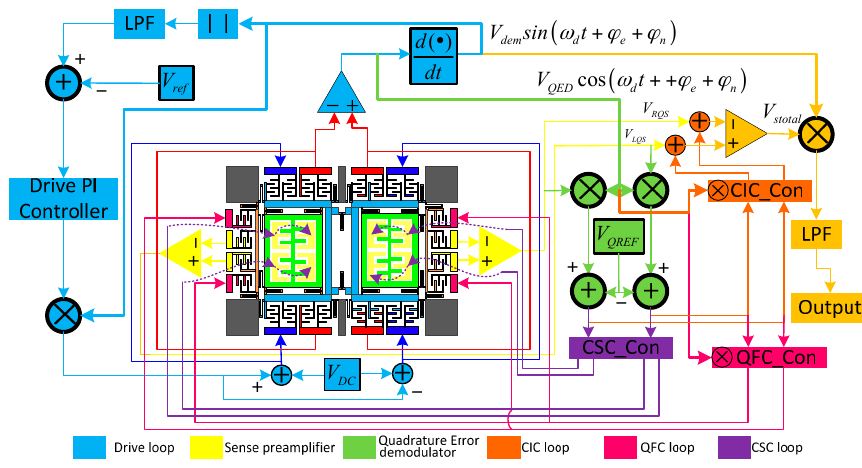
Figure 6. Diagram of the gyro monitoring system.